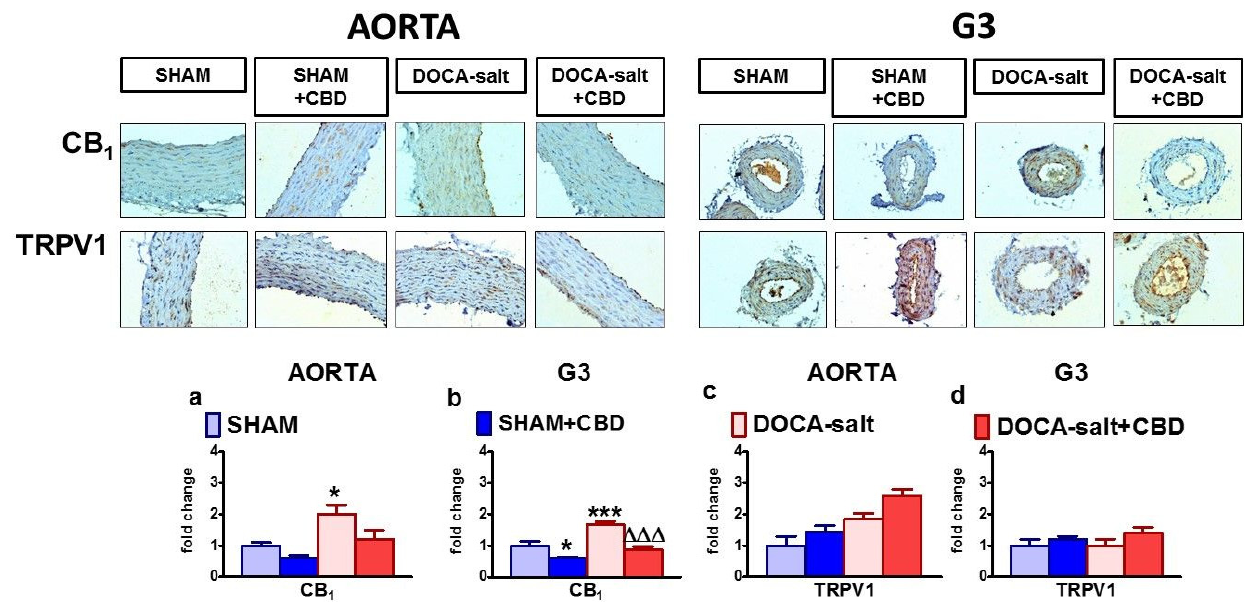
Figure 5. Representative micrographs of the influences of cannabidiol (CBD) and its vehicle on immunohistochemical staining of CB 1 and TRPV1 receptors in the aortic walls and mesenteric G3 arteries isolated from deoxycorticosterone-induced (DOCA-salt) and normotensive control sham-operated (SHAM) rats (magnification 200×). The bar graphs illustrate the fold changes of the percentage area stained for CB 1 ( a , b ) and for TRPV1 receptors ( c , d ) in the aortic walls ( a , c ) and mesenteric G3 arteries ( b , d ) isolated from deoxycorticosterone-induced (DOCA-salt) and normotensive control sham-operated (SHAM) rats. CBD (10 mg/kg) or its vehicle was injected i.p. every 24 h for 14 days. Mean ± SEM, n = 5 tissues for each bar. * p < 0.05 and ***, ∆∆∆ p < 0.001 compared to the respective control groups (* SHAM or ∆ DOCA-salt), as determined by one-way ANOVA followed by Bonferroni’s multiple-comparison tests.